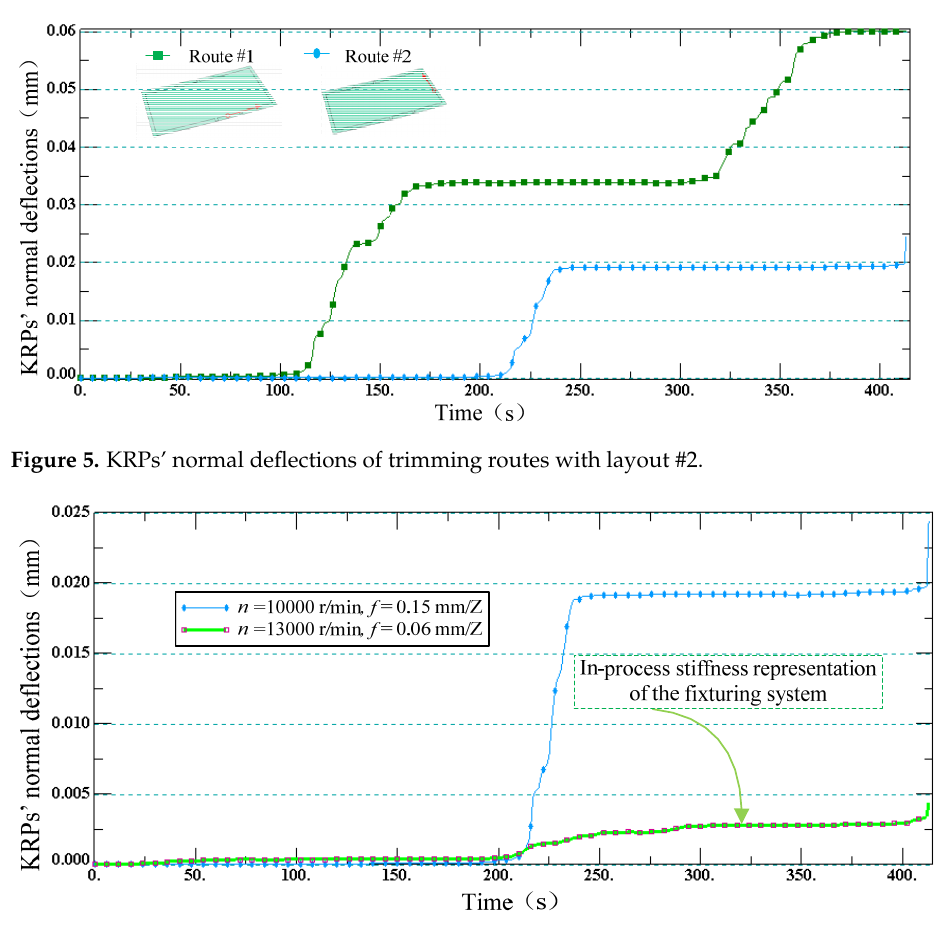
Figure 4. KRPs’ normal deflections with different fixturing layouts.